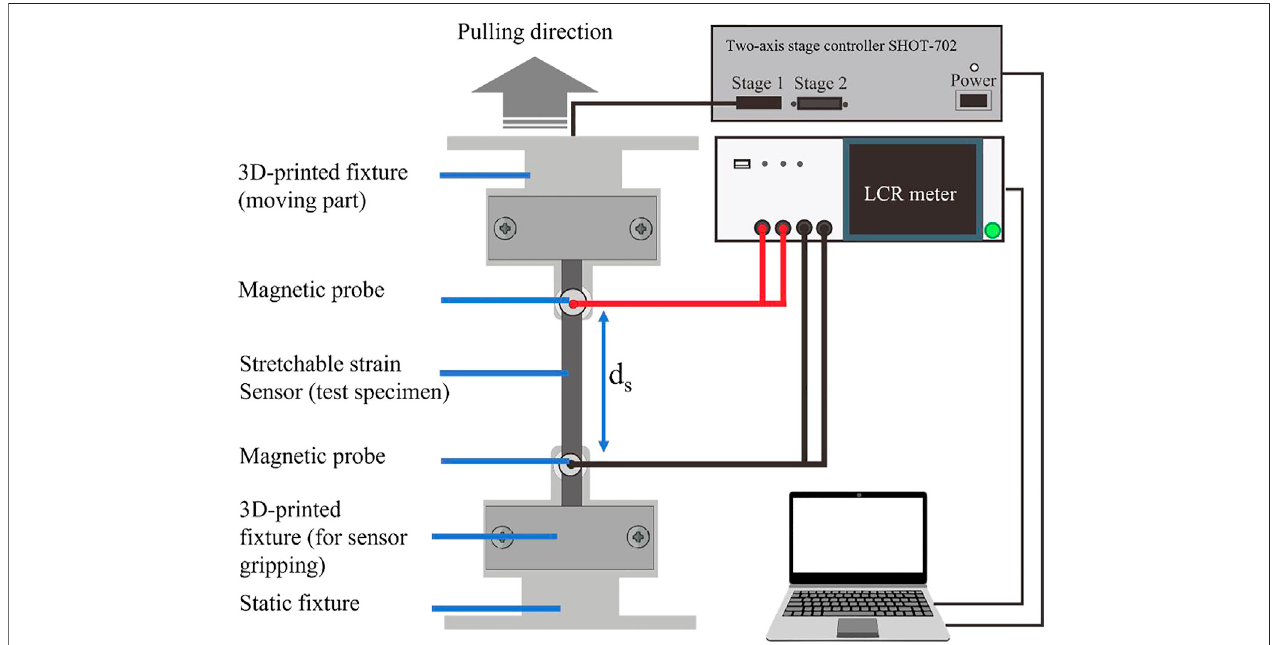
FIGURE 4 | Electromechanical experimental setup for sensor characterization.